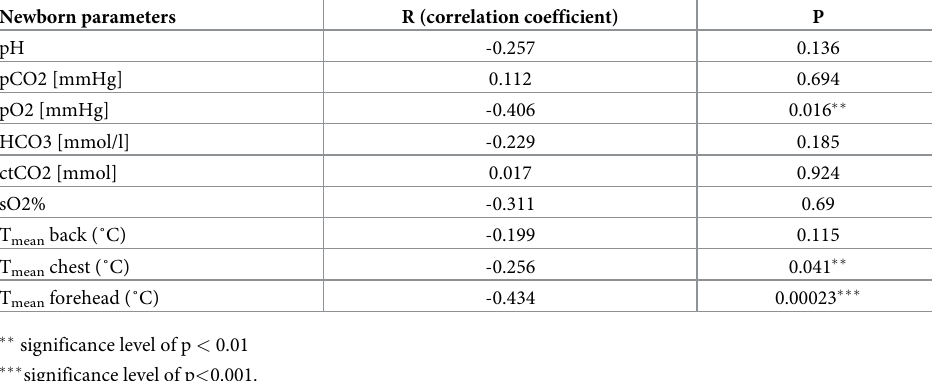
Table 4. Correlation of the duration of the second stage of labour with biochemical parameters and temperatures of selected body surface areas in newborns born by vaginal delivery. Newborn